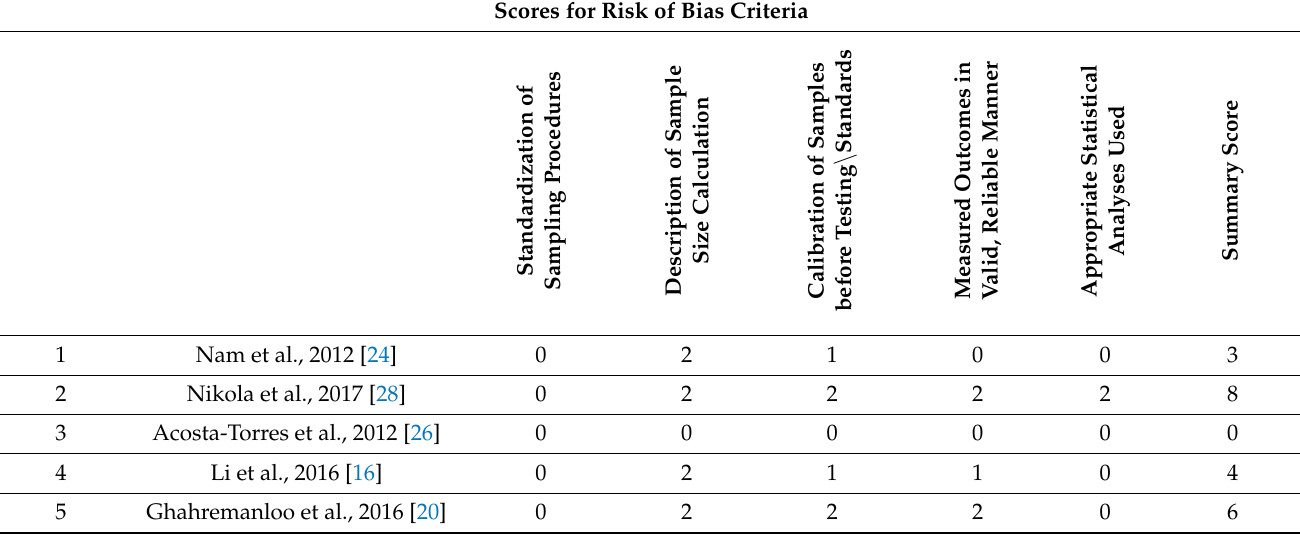
Table 3. Risk of bias for laboratory studies.